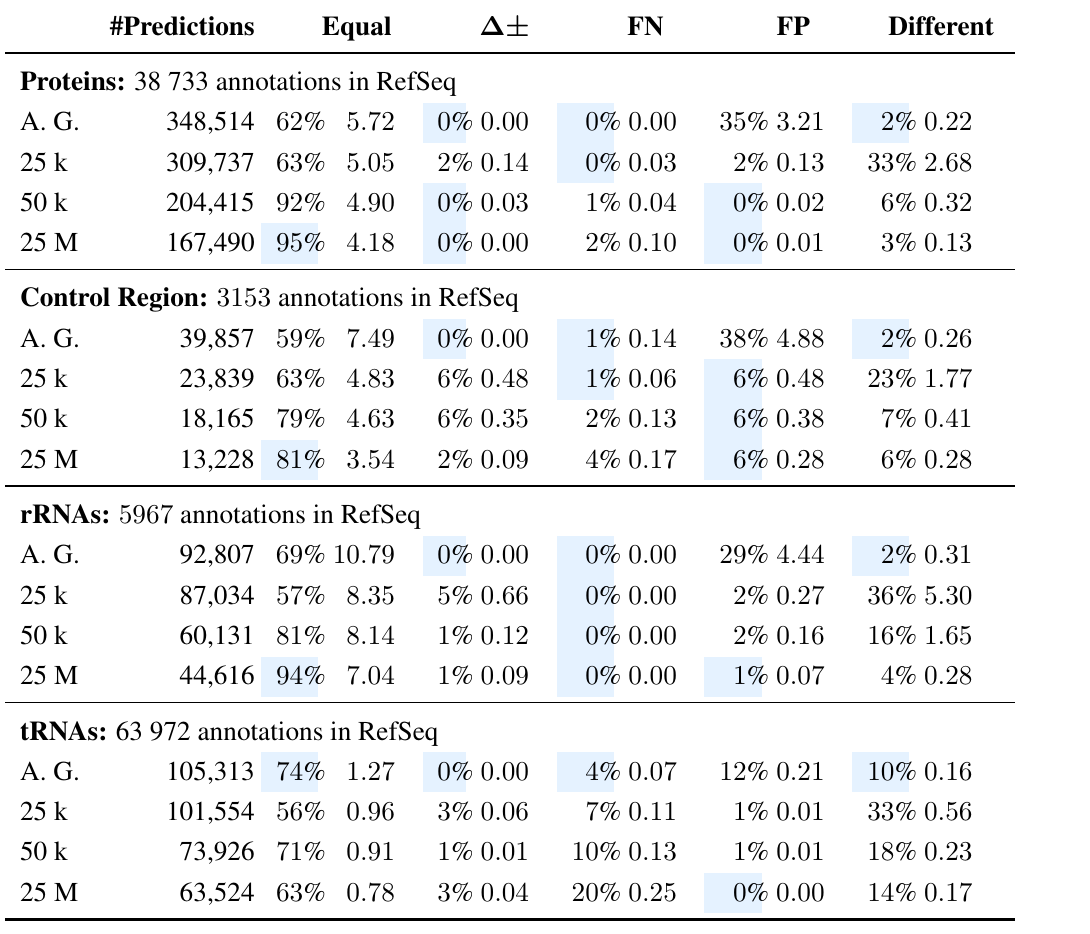
Table 2. Comparison of the annotations produced by the different methods (annotation guided and probability based with z = 25 k , 50 k, 25 M) and the ones given by the RefSeq database. The predictions proposed by the algorithms and the respective gene annotation that covers the prediction the most but at least 25% are classified as (1) equal if both annotate the same gene and strand; (2) ∆ ± if they annotate the same gene but give different strands; (3) false negatives (FN) if a RefSeq annotation is unpaired; (4) false positive (FP) if a predicted fragment remains unpaired; and (5) different if the pair annotates different